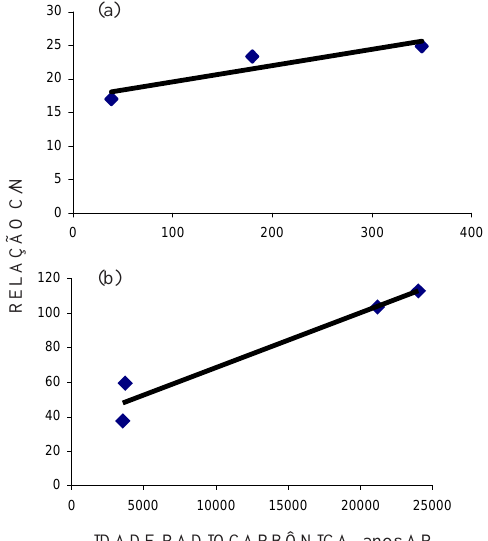
Figura 6. Idades radiocarbônicas e relações C/N nas camadas do Neossolo Flúvico - P1 (a) e do Paleossolo - P2